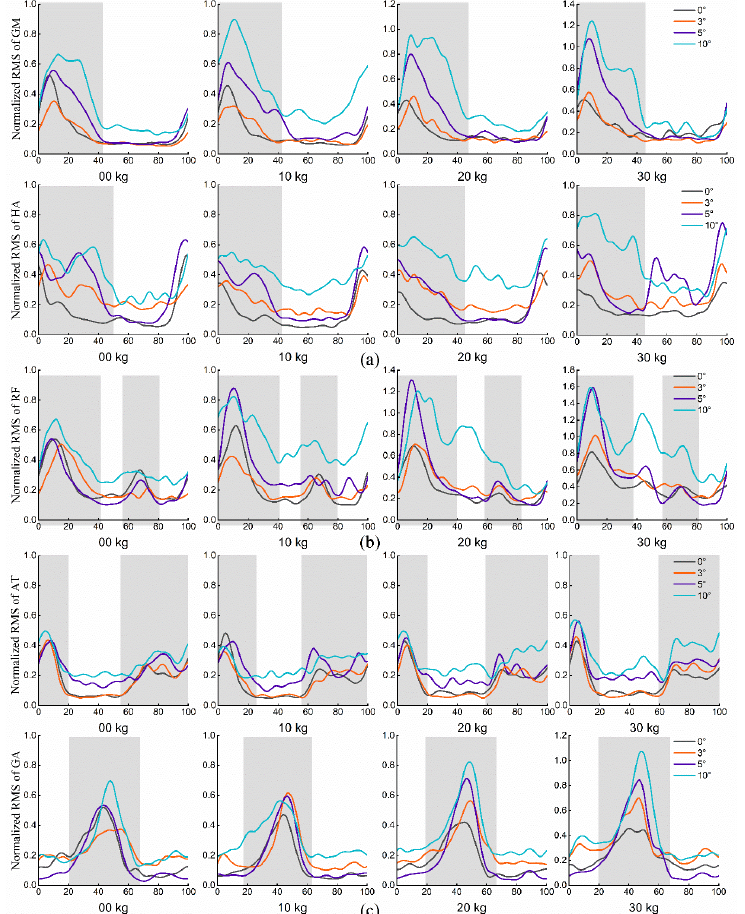
Figure 5. The muscle activity of leg muscles in one gait during walking with different backpack load masses across all grades, normalized to the mean activity during level walking without backpack loads: ( a ) The muscle activity of the hip extensor muscles. ( b ) The muscle activity of the knee extensor muscle. ( c ) The muscle activity of the ankle muscles. The different colors of the curves had the same representation as those colors in Figure 4. The gray area represented the higher muscle activation duration in one gait.